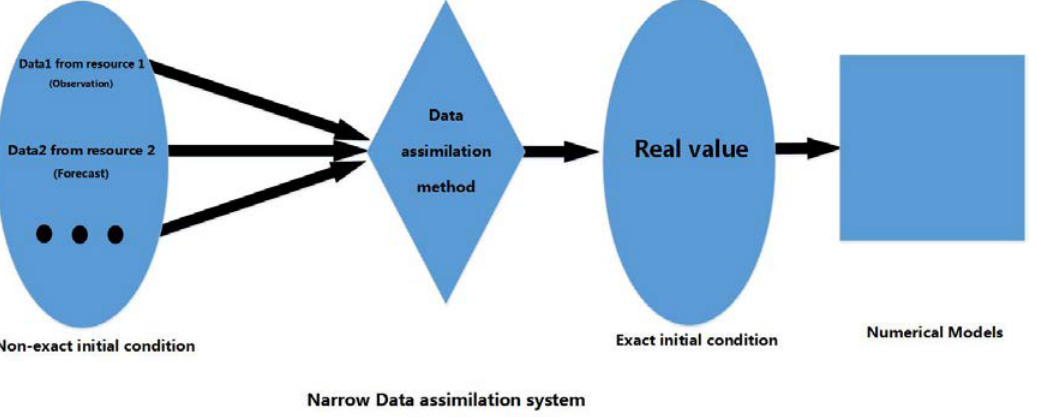
Figure 4. Narrow (Prior) Data assimilation system.